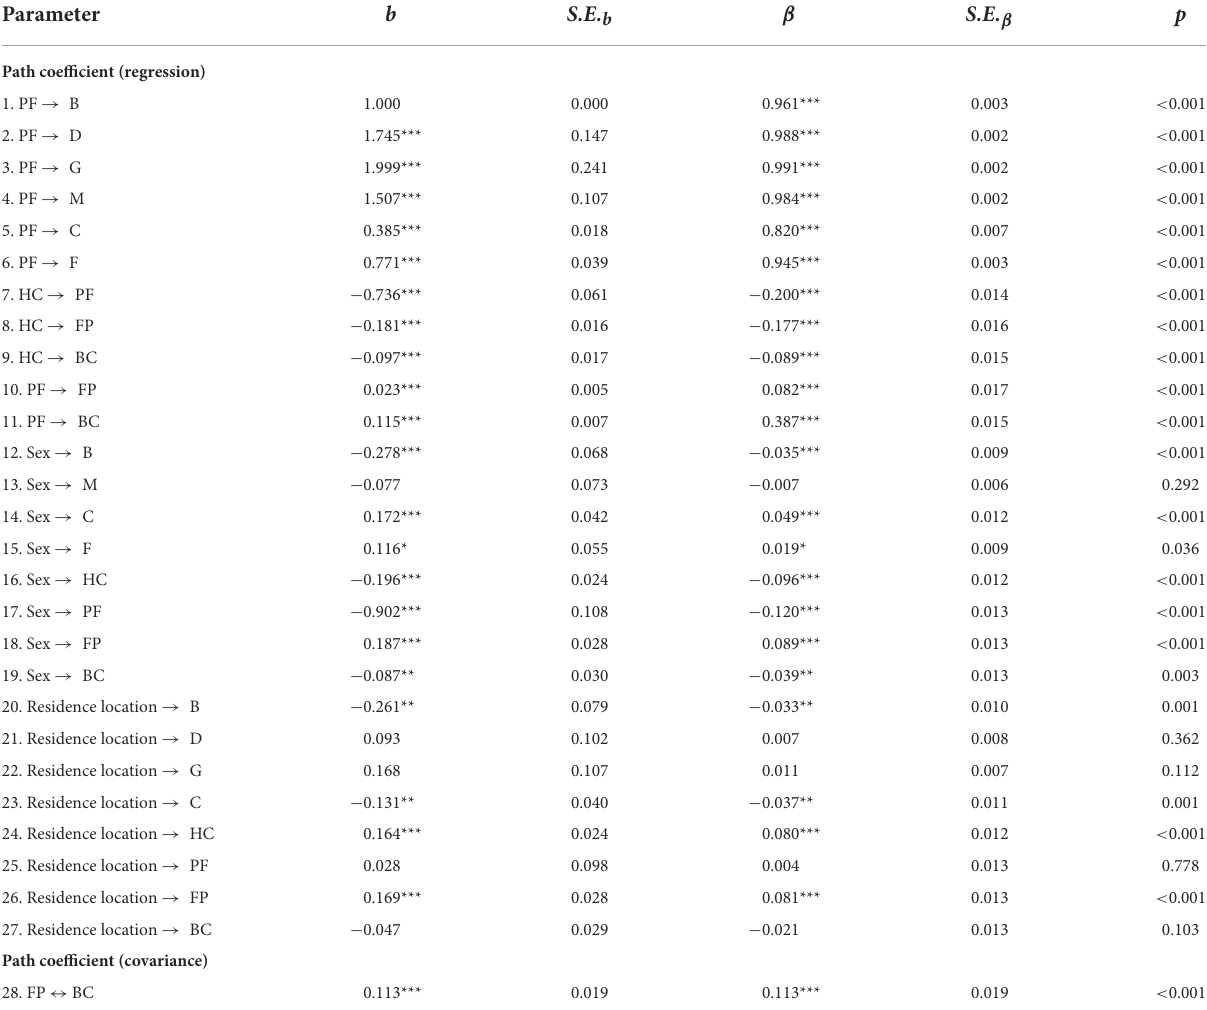
TABLE 4 Parameter estimates for the associations between life prior to death and quality of death.